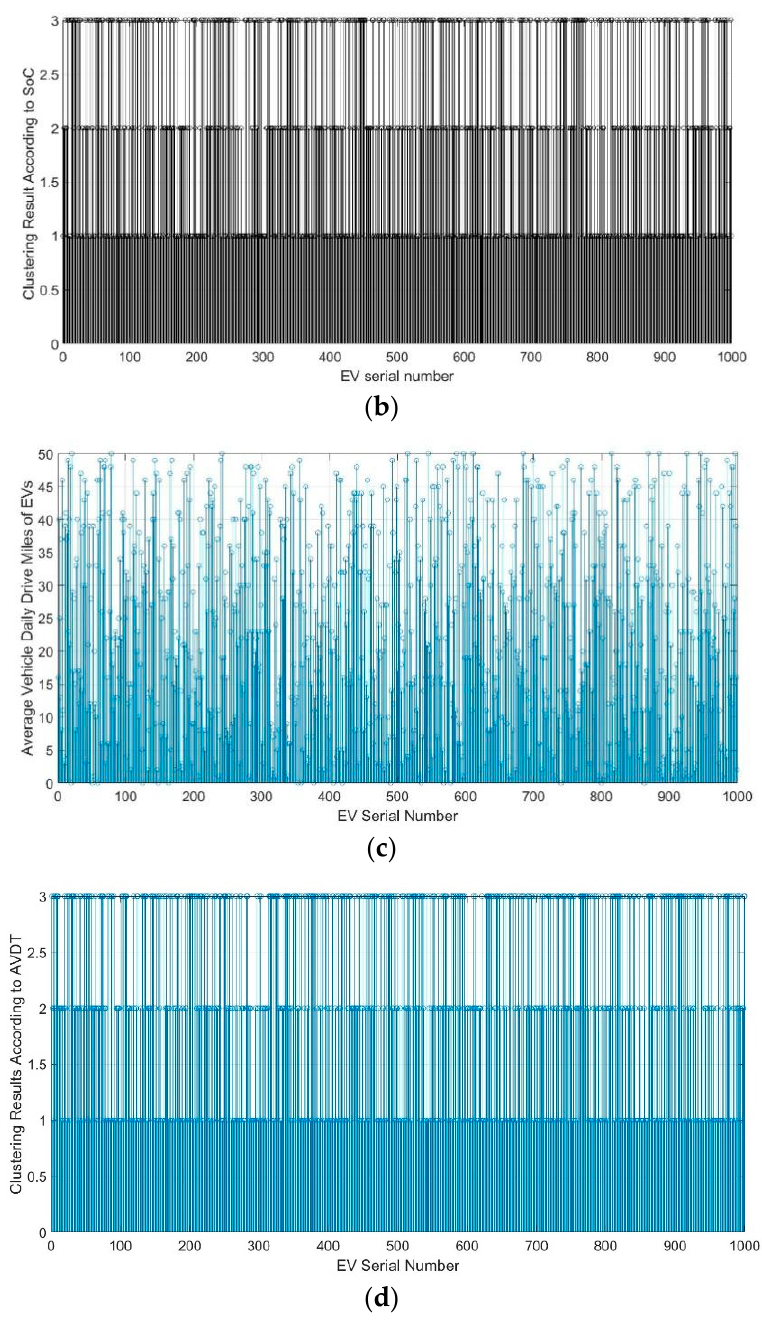
Figure 9. ( a ) Distribution of battery state of charge of 1000 EV; ( b ) Clustering results of EVs according to their SoC value; ( c ) Distribution of the average vehicle daily travel miles of 1000 EV; ( d ) Clustering results of EVs according to the average vehicle daily travel miles of 1000 EV.